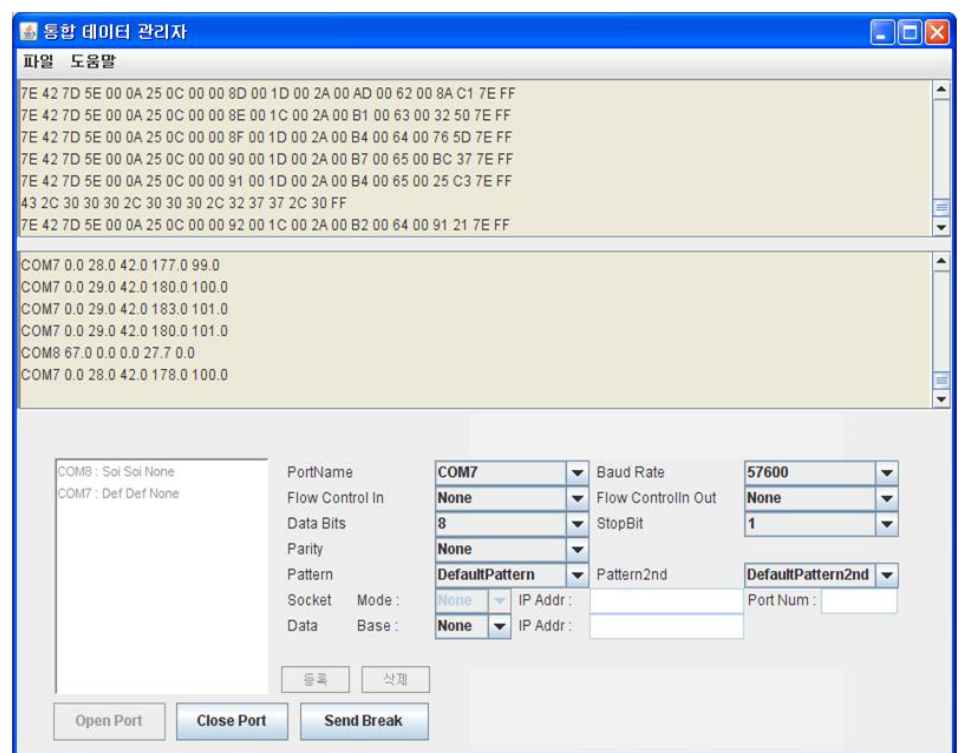
Figure 14. Implementation of the Sensor